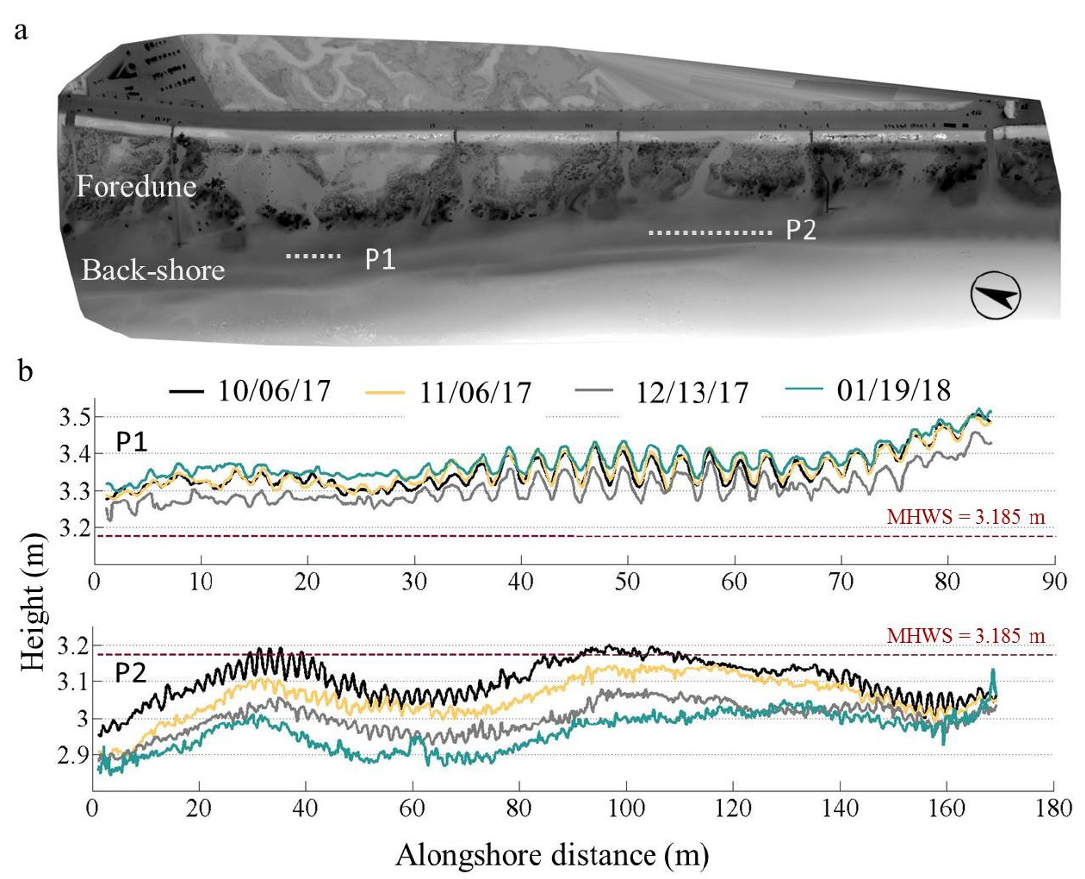
Figure 3. ( a ) Locations of the alongshore profiles P1 and P2; ( b ) temporal evolution of the rhythmic features from October 2017 to January 2018 in both profiles. Note the mean high water spring level (MHWS) of 3.185 m in the dashed red line.